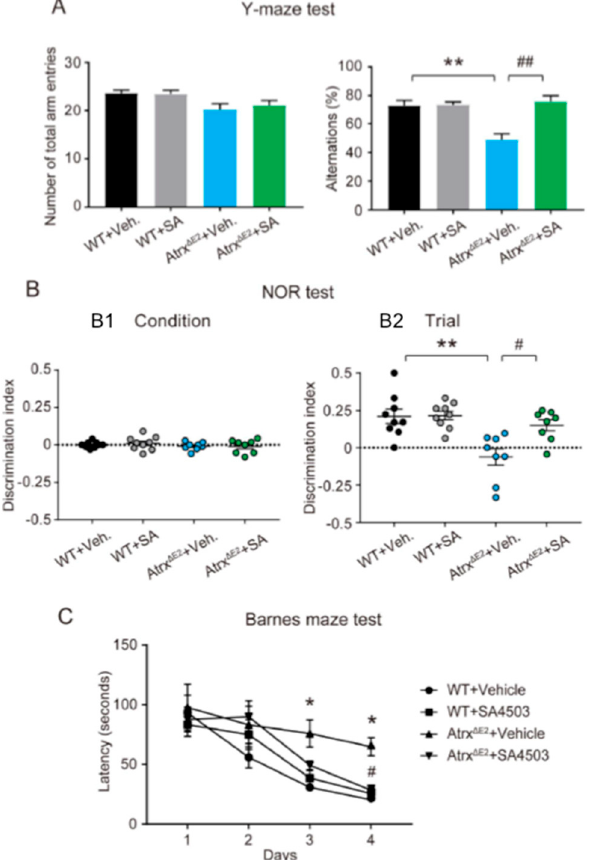
Figure 3. SA4503 treatment decreased cognitive deficits in Atrx ∆ E2 mice based on memory-related tests. ( A ) Number of total arm entries (left) and alternations (right) in a Y-maze test. ** p < 0.01, versus vehicle-treated WT mice; ## p < 0.01, versus vehicle-treated Atrx ∆ E2 mice by one-way ANOVA with post hoc Tukey’s test; F (3, 18) = 12.98. ( B ) Novel object recognition task. Discrimination index of object exploration during the sample phase (left), and while exploring familiar and new objects in the test phase after 24 h (right). ** p < 0.01, versus vehicle-treated WT mice; # p < 0.05, versus vehicle-treated Atrx ∆ E2 mice by one-way ANOVA with post hoc Tukey’s test; F (3, 30) = 8.898. ( C ) Barnes maze test measurement of total latency (s) to reach the target hole. * p < 0.05 by two-way ANOVA with post hoc Bonferroni’s test; F (3, 120) = 6.535, p < 0.01 (group); F (3, 120) = 25.16, p < 0.01 (day), F (9, 120) = 1.184, p = 0.3112 (interaction between group and day). Each bar represents the mean ± SEM. Abbreviations: Veh., vehicle; SA, SA4503. WT + Vehicle: n = 9 mice, WT + SA4503: n = 9 mice, Atrx ∆ E2 + Vehicle: n = 8 mice, Atrx ∆ E2 + SA4503: n = 8